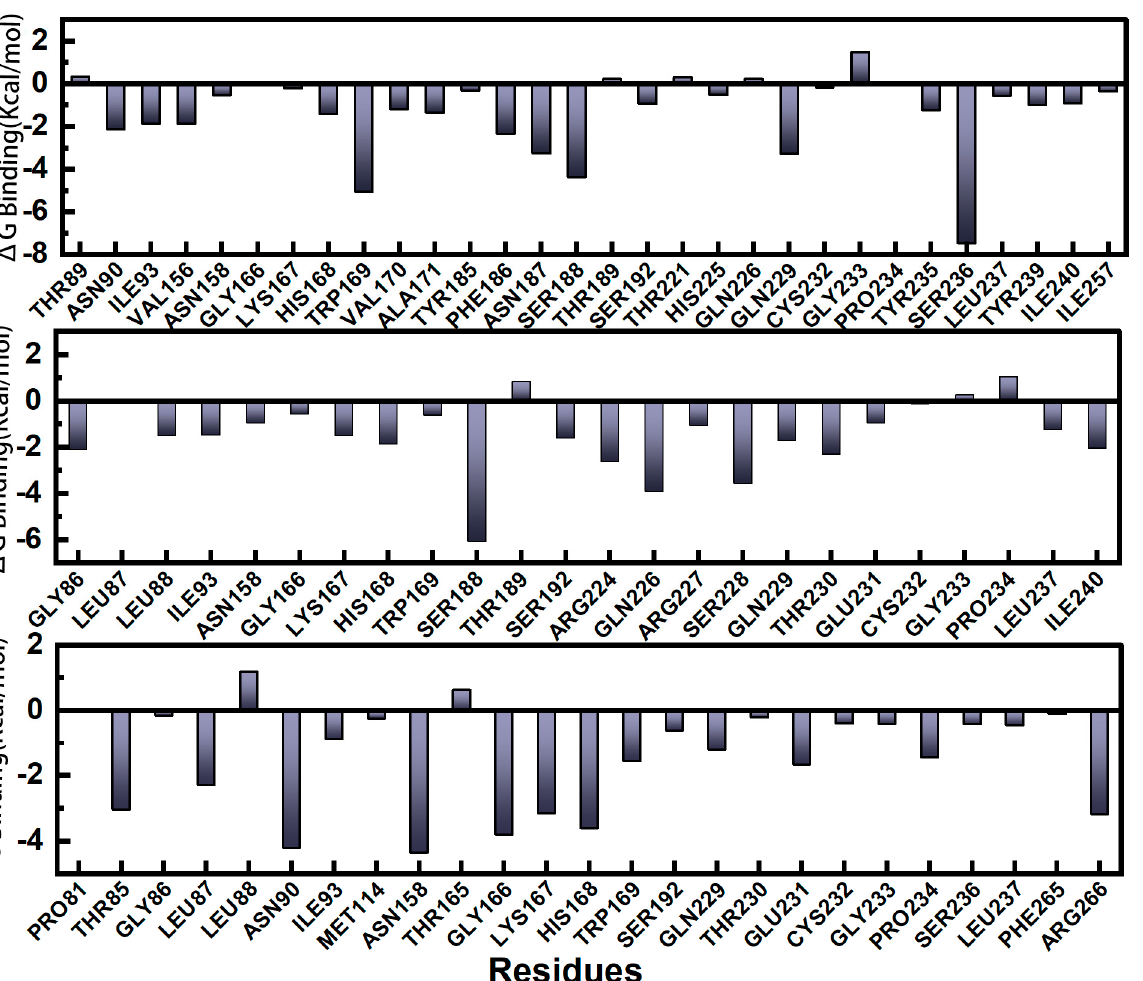
solvation free energy -T ∆ S, Interaction Entropy. ∆ G Binding, Total energy.